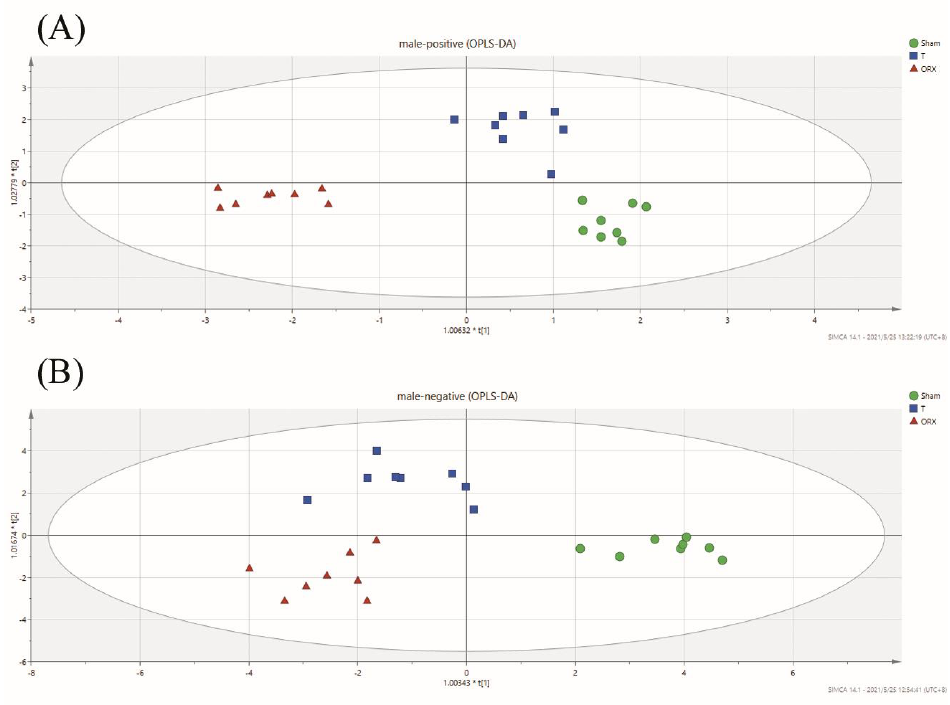
Figure 2. Score scatter plots for OPLS-DA analysis in ( A ) positive mode and ( B ) negative mode. The asterisk (*) in front of the horizontal and vertical axes labels of the OPLS-DA score plot indicates that the corresponding scores are scaled scores.